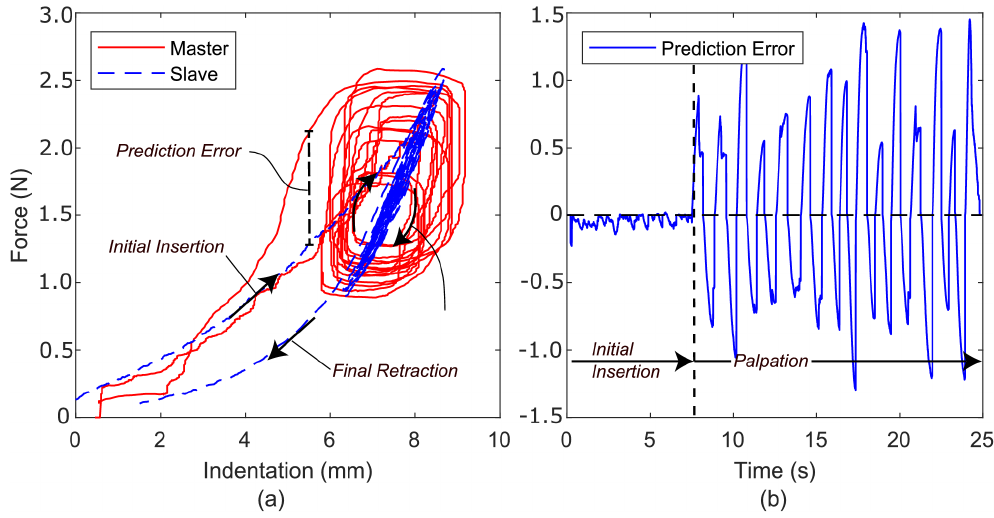
Figure 6. ( a ) Force profiles for both the slave and master as the slave interacts with polyurethane foam using a direct force-feedback channel. ( b ) Prediction error.